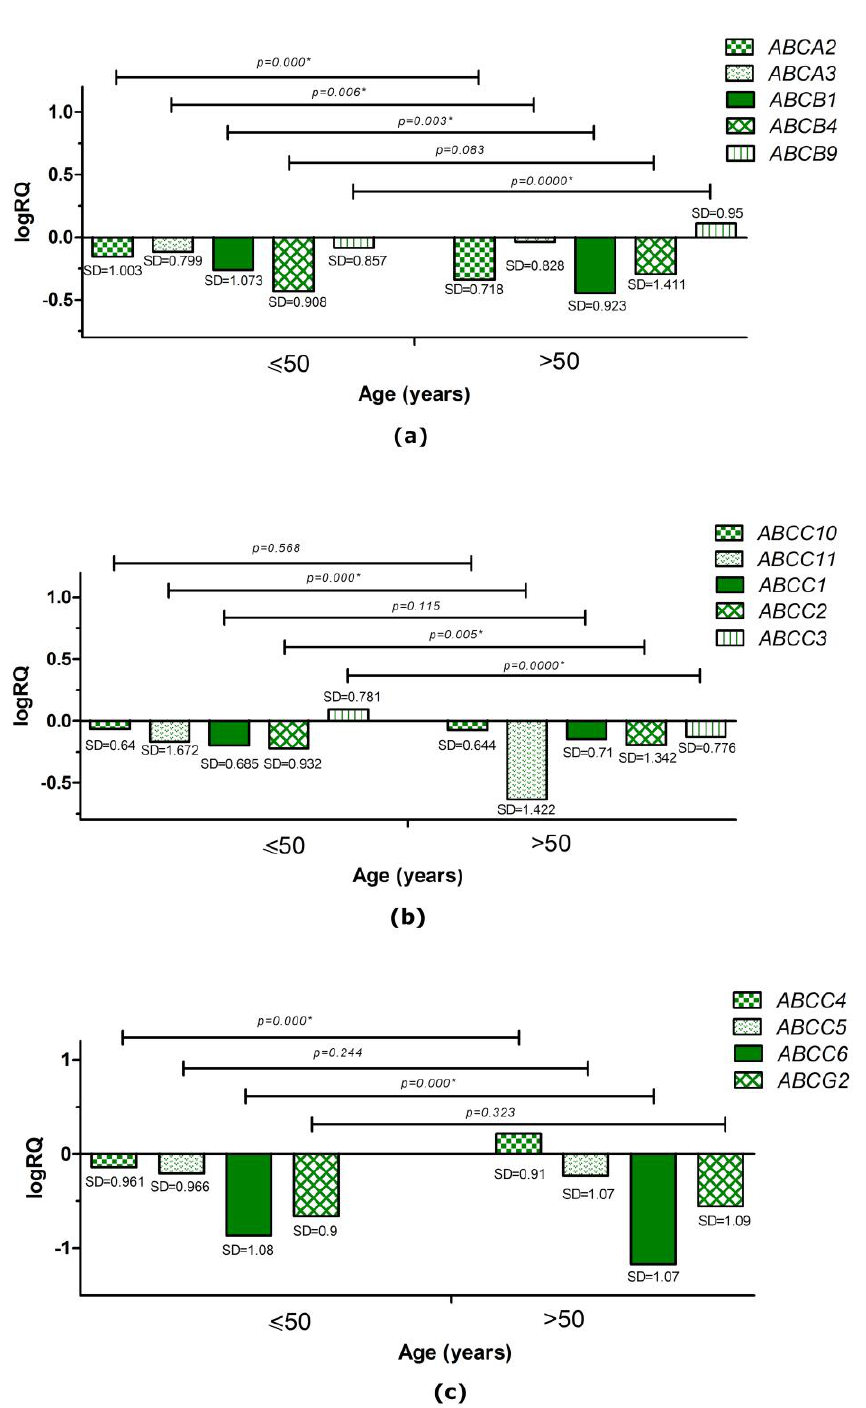
Figure 4. Mean expression level (logRQ) of the ABCA2 , ABCA3 , ABCB1 , ABCB4 , and ABCB9 genes ( a ); the ABCC10 , ABCC11 , ABCC1 , ABCC2 , and ABCC3 genes ( b ); and the ABCC4 , ABCC5 , ABCC6 , and ABCG2 genes ( c ) in triple-negative breast cancer tissue compared to tissue normal in age groups ( ≤ 50 years, >50 years). * Significance level of the U Mann–Whitney